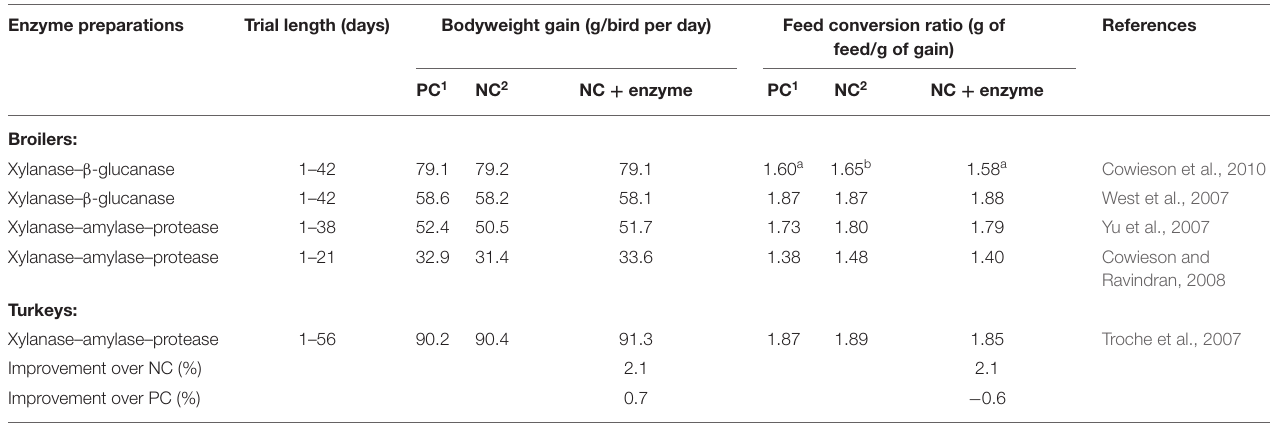
TABLE 4 | Growth performance of broiler chickens and turkeys fed corn-soybean meal based diets with or without different cocktail of enzymes [adapted from Slominski (2011) ]. Enzyme preparations Trial length (days) Bodyweight gain (g/bird per